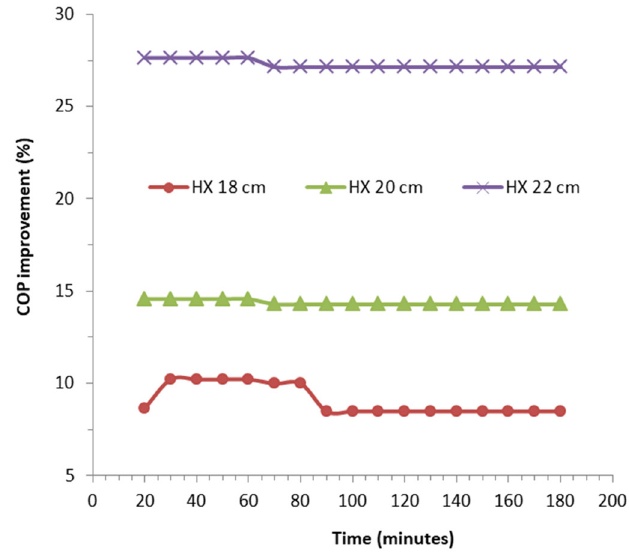
Figure 13. COP improvement of the air conditioner using subcooler for three different lengths of heat exchanger.